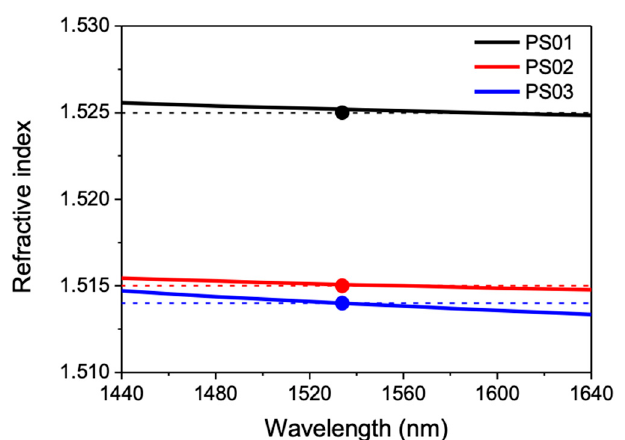
Figure 1. (Continuous lines) Refractive index of the samples PS01, PS02, and PS03 as a function of wavelength in the 1460–1625 nm interval determined from ellipsometry measurements. The symbols (and dashed lines) correspond to the index values of the three samples at 1530 nm estimated from the polarizabilities of the glass constituents, as explained in the text.